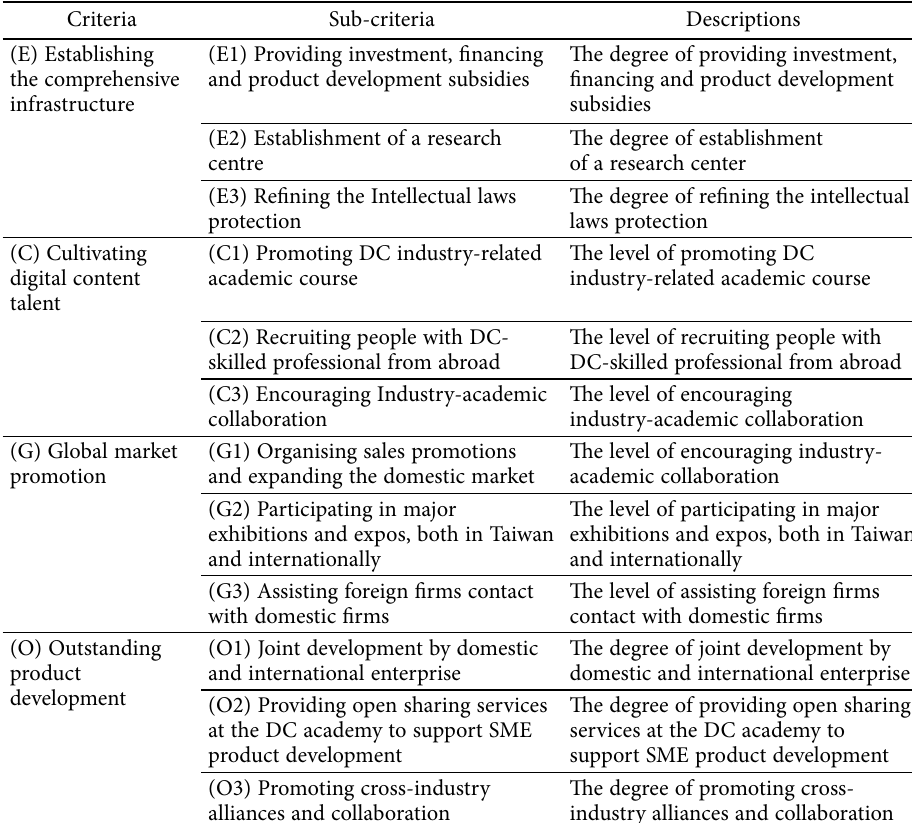
Table 1. The criteria and sub-criteria for DC development strategy Criteria